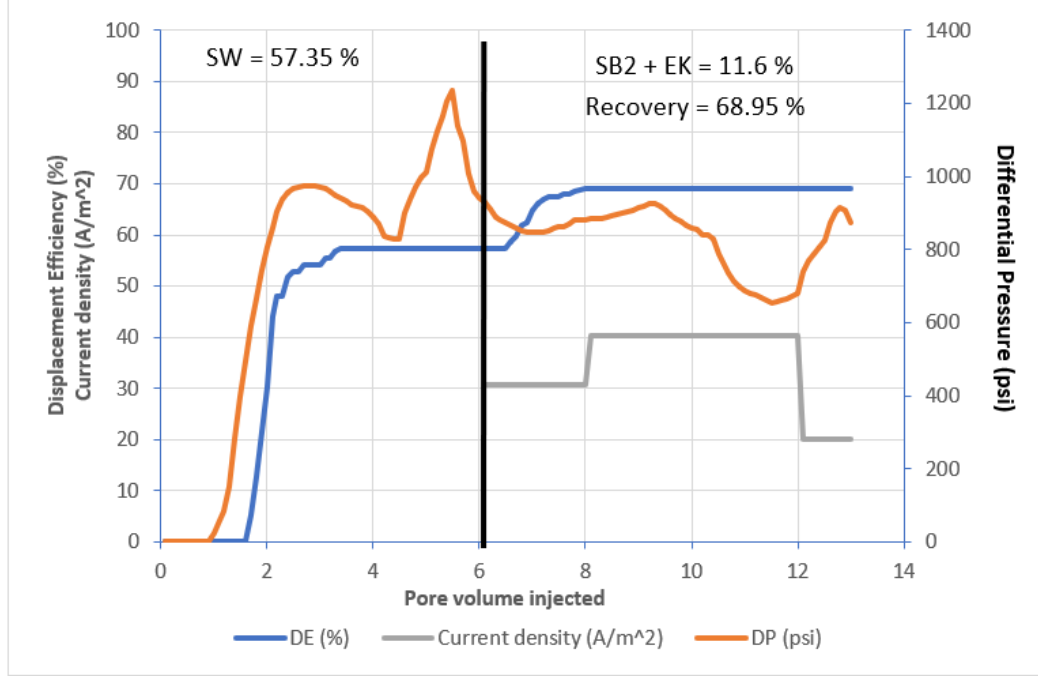
Table 14. Summary of CF7.